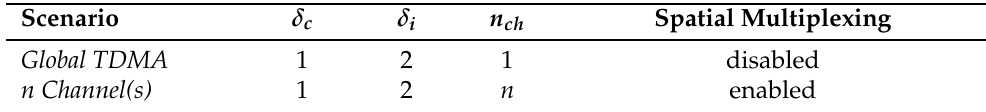
Table 8. Summary of slotframe length experimental scenarios.